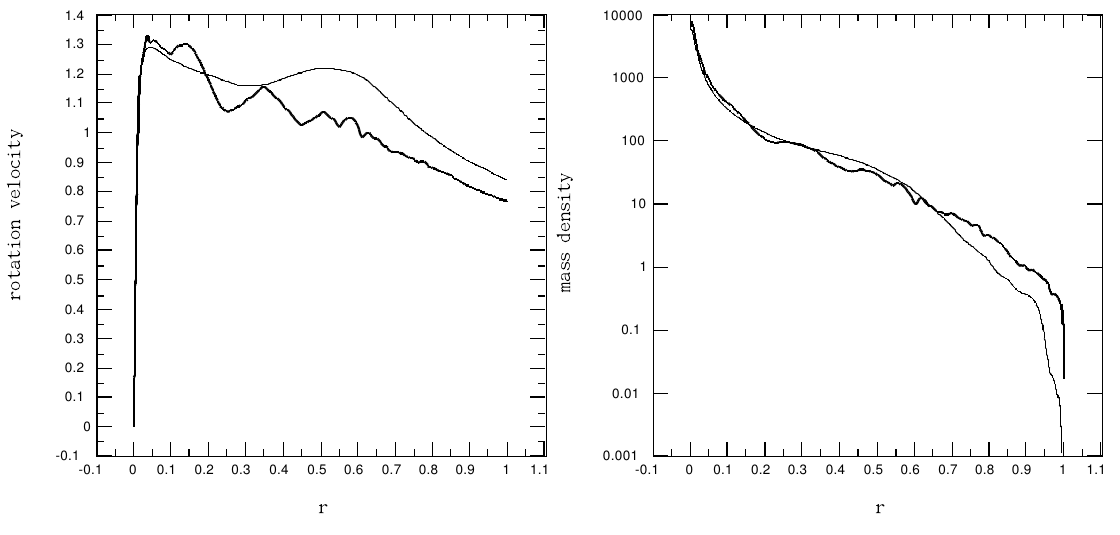
Figure 1. Profiles of NGC 4736 rotation velocity V ( r ) and mass density ρ ( r ) , with the thick line for that of the H I Nearby Galaxy Survey (THINGS) and the thin line for that from Sofue. The computed values of the galactic rotation number, A , are 1 . 9656 and 1 . 5908 for the cases of THINGS and Sofue,